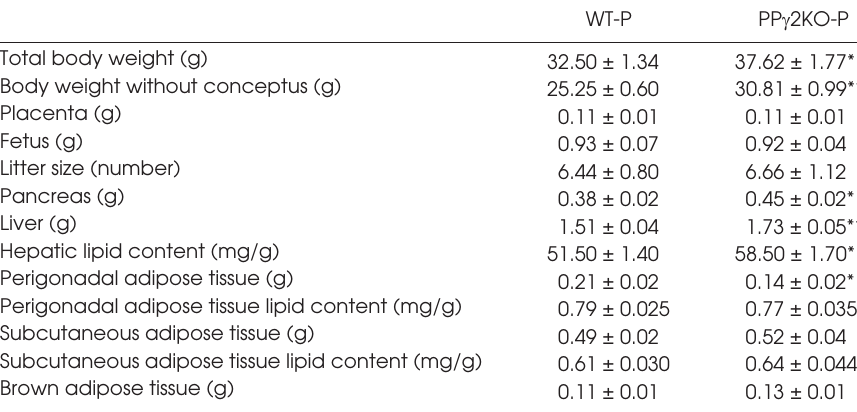
Table 1. Body weight, weight of fetuses, body mass distribution and tissue lipid content during pregnancy in WT and PPAR γ 2KO